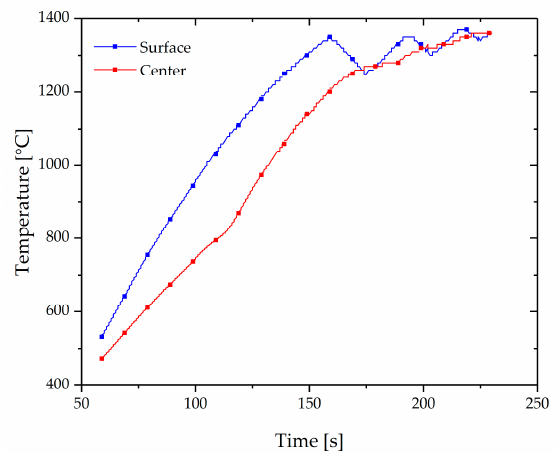
Figure 3. Example of the recorded temperature evolution in the center and surface of the billet during pulse heating for Trial 1.